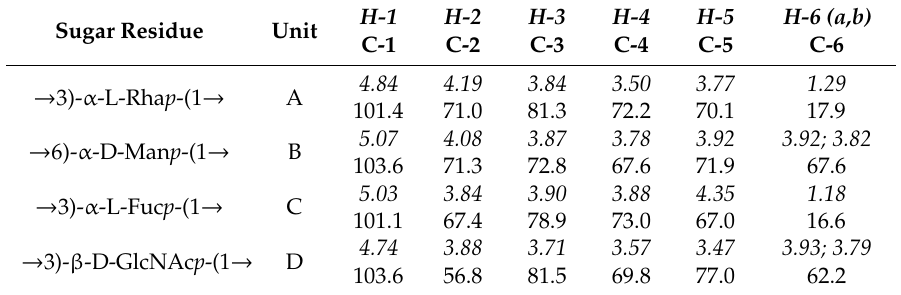
Figure 3. Part of a 2D 1 H, 13 C HSQC spectrum of P. agglomerans 8488 OPS. The corresponding parts of the 13 C and 1 H-NMR spectra are displayed along the vertical F1 and horizontal F2 axes, respectively. Arabic numerals refer to the H / C pairs in the OPS components denoted as indicated in Table 1. ( A ) region of the anomeric atom signals, ( B ) other sugar ring atom signals region. Table 2. The 1 H and 13 C-NMR chemical shifts ( δ , ppm) of P. agglomerans 8488